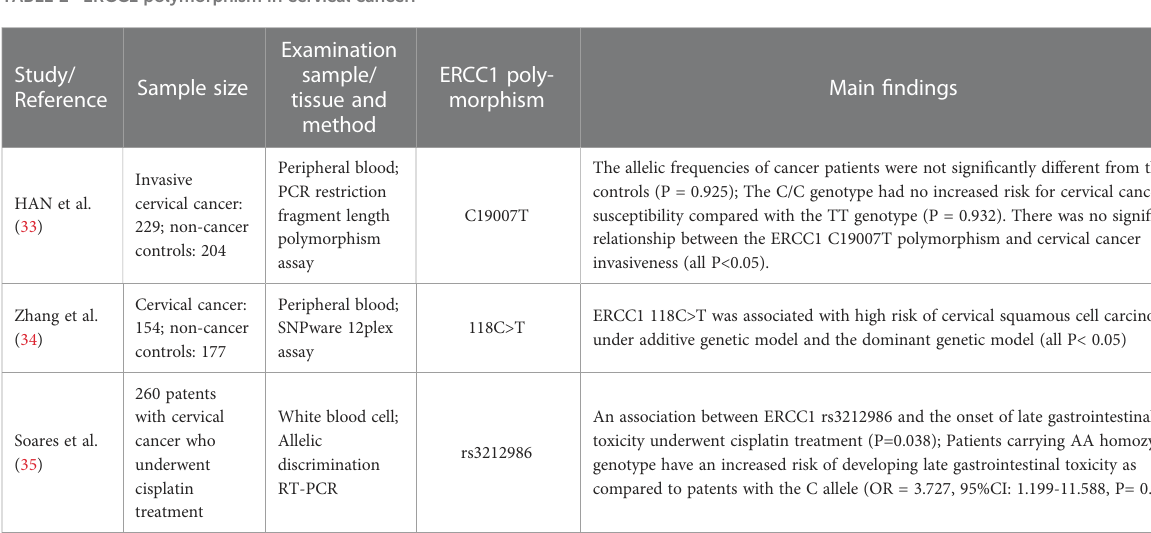
TABLE 2 ERCC1 polymorphism in cervical cancer.